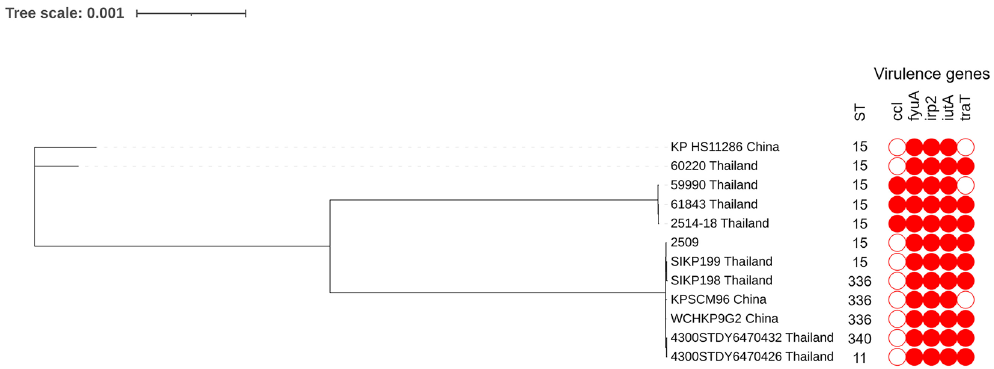
Figure 4. Phylogenetic tree based on SNP, STs, and virulence gene patterns in K. pneumoniae . Virulence genes are represented by respective red-colored shapes. The tree was visualized and annotated using